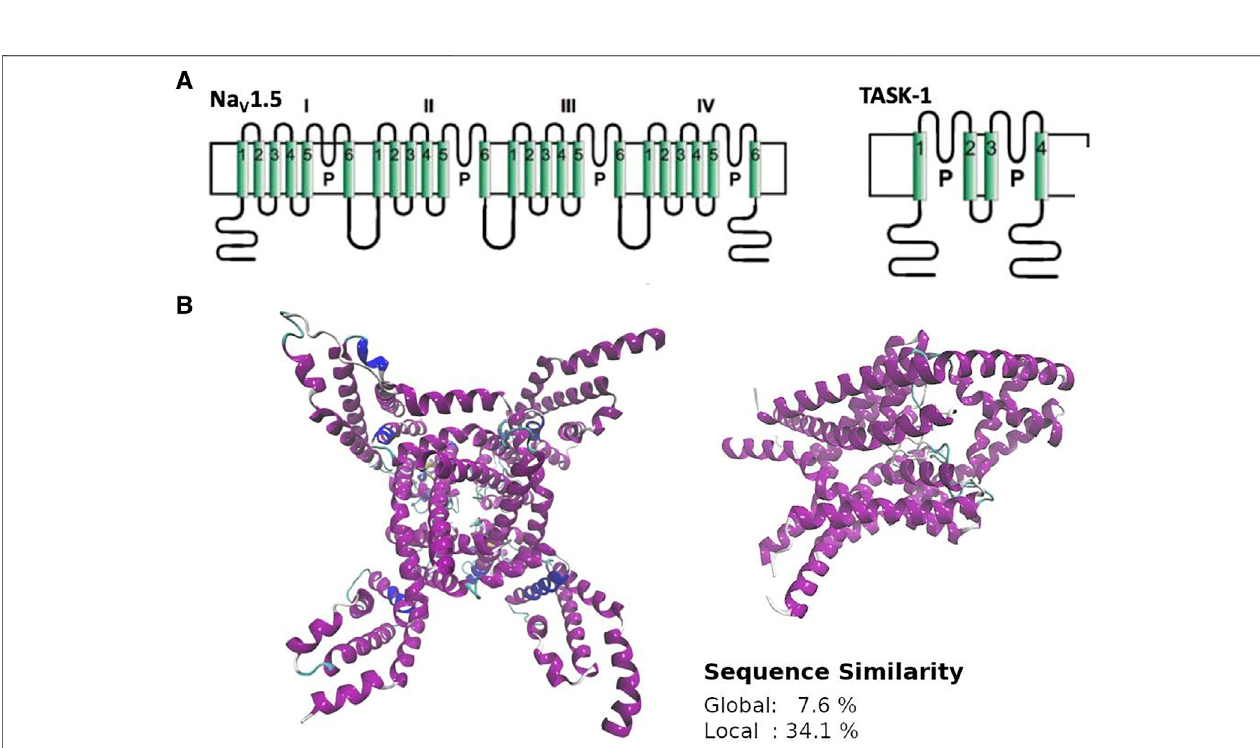
FIGURE 5 | General overview of structure (A) , topology (B) and sequence (inset) similarity of NaV1.5 and TASK-1. NaV1.5 corresponds to the PDBid:6UZ3 and TASK-1tothe PDBid:6RV3. NaV1.5 isamonomer with four domains, each containingapore sequence and TASK-1isadimer withfour transmembranesegmentsand two pore sequences each